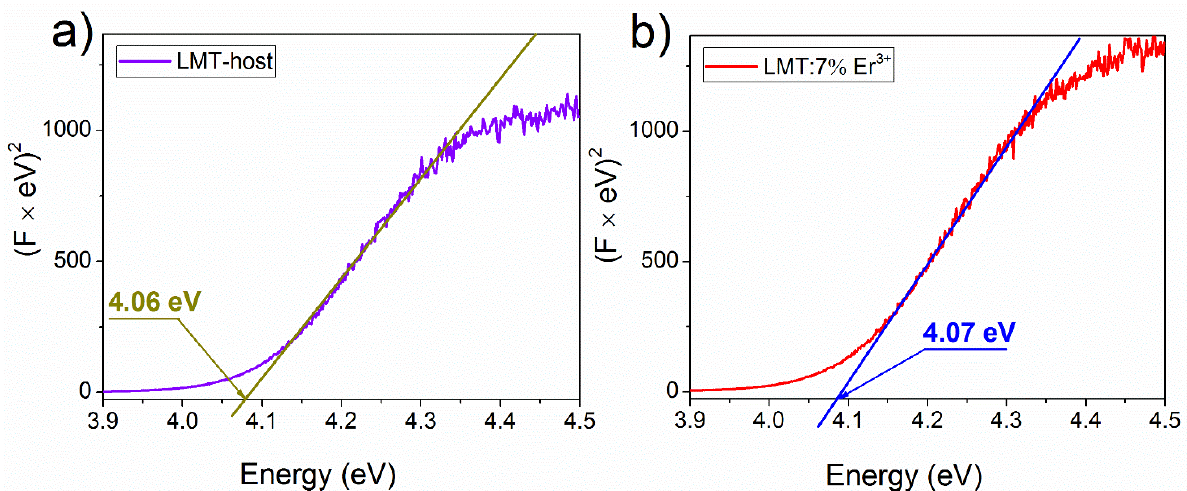
Figure 5. Forbidden energy bandgaps (E g ) of La 2 MgTiO 6 host ( a ) and La 2 MgTiO 6 :7% Er 3+ ( b ) calculated from the absorption spectra obtained from the reflection spectra applying the modified Kubelka–Munk function (also known as the Tauc method).